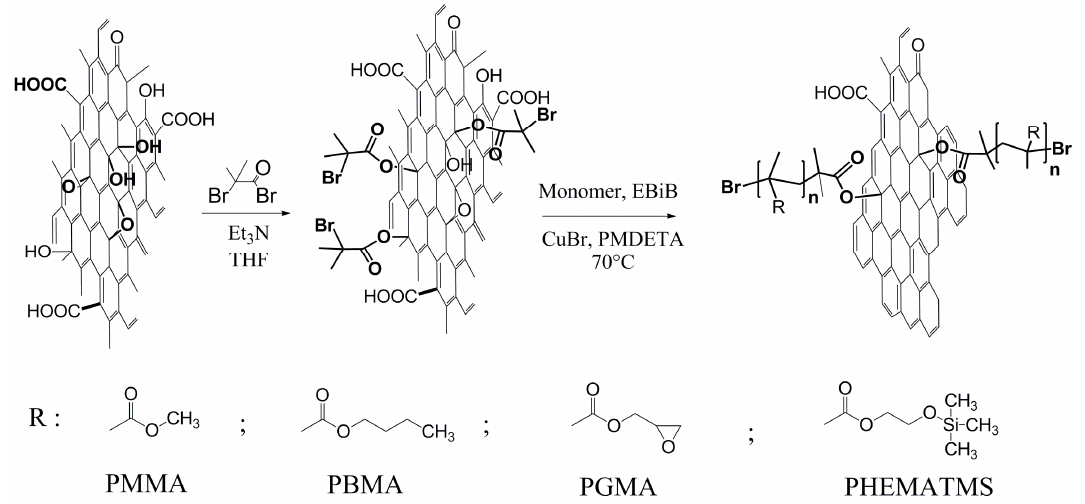
Scheme 1. Schematic illustration of the modification of graphene oxide (GO) surface by atom transfer radical polymerization (ATRP) initiator and subsequent surface-initiated (SI-ATRP) of various monomers. R from the scheme represents corresponding monomeric moieties. Table 1. Molar ratios of individual reactants and characterization of polymers grown form sacrificial initiator.